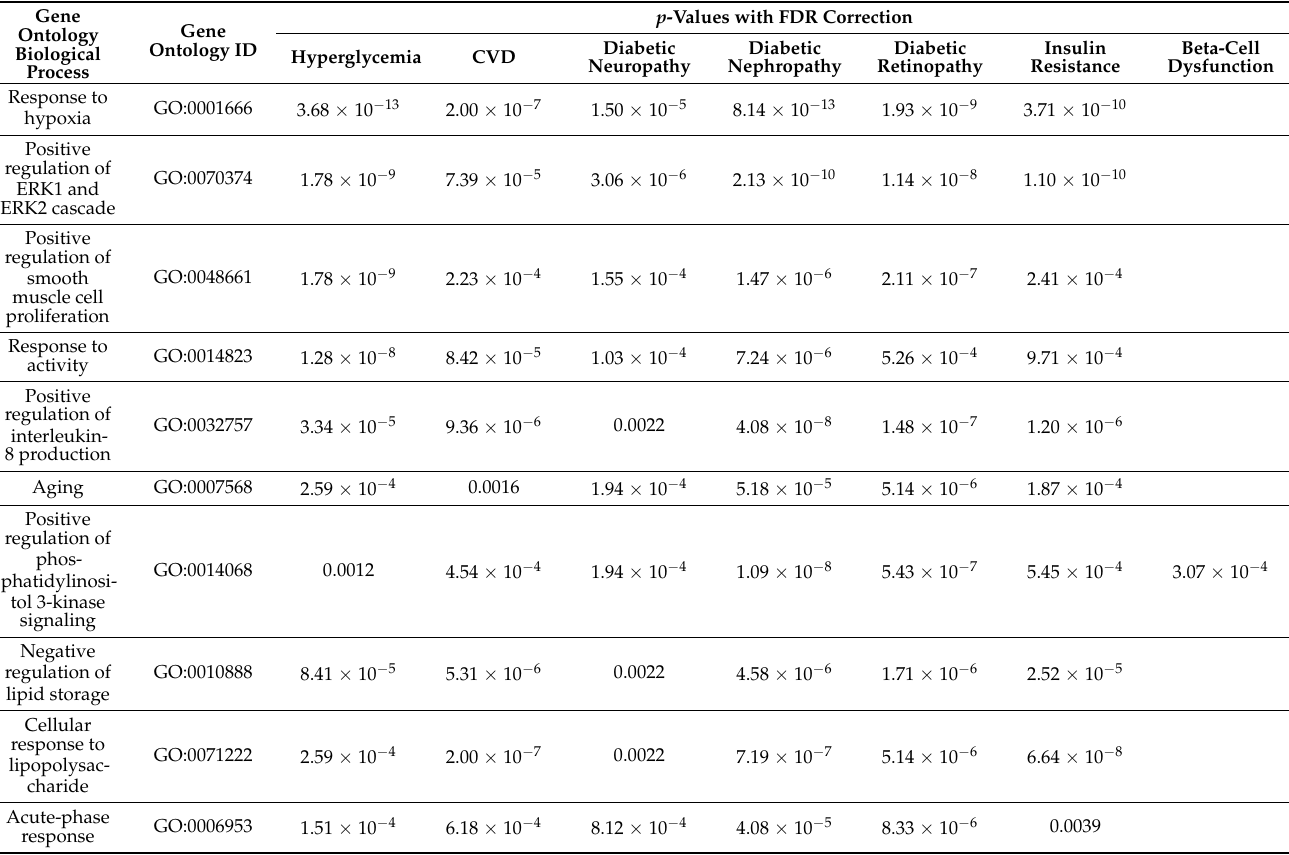
Table 5. Most overrepresented GO biological processes that are common for the sets of genes linked with DPP4 and are associated with hyperglycemia, CVD, diabetic neuropathy, diabetic nephropathy, diabetic retinopathy, insulin resistance, and beta-cell